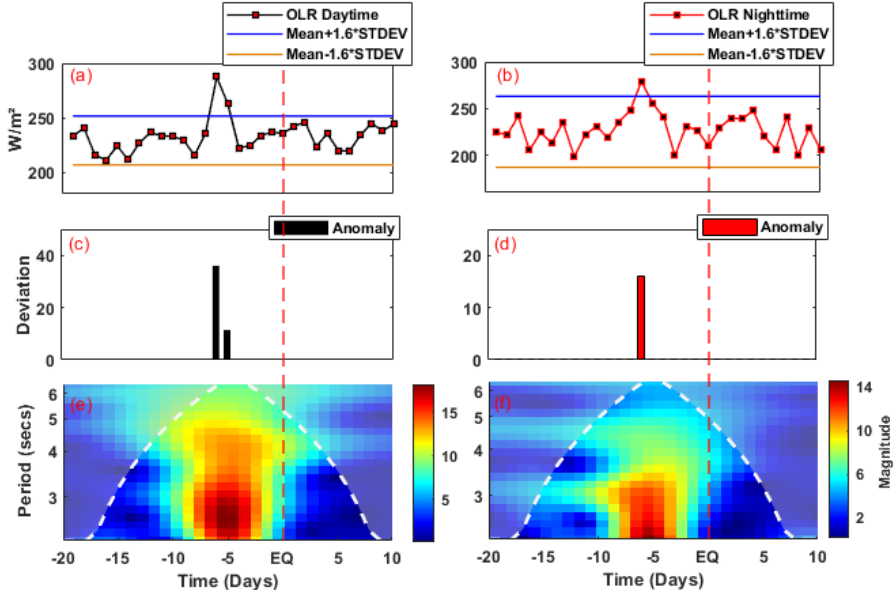
Figure 2. ( a ) Daytime OLR averaged time series data with confidence bounds, ( b ) Time series data of OLR nighttime with confidence bounds, ( c ) The deviation of daytime OLR values from confidence bounds, ( d ) Nighttime OLR deviation from the confidence bounds, ( e ) Wavelet transformation of the daytime OLR time series data, ( f ) Wavelet transformation analysis of nighttime OLR time series data. The white dashed line marks cone of influence and red dashed line shows the earthquake day. The * is for multiplication.